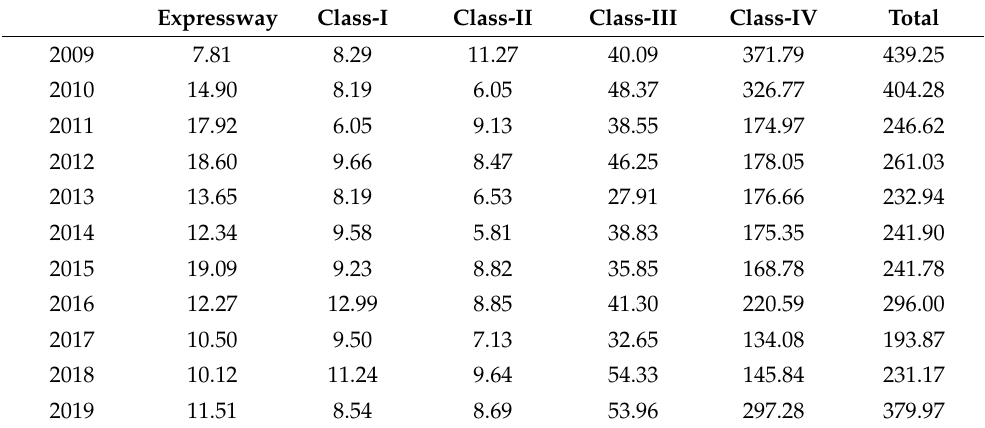
Figure 6. GHG emissions from the construction of road each type during 2009–2019. Table 4. Detailed figures of GHG emissions from the construction of each road type during 2009–2019 (unit: million t CO 2 e).